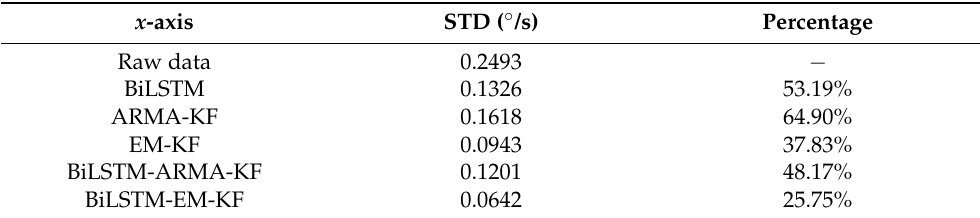
Figure 9. Comparison of error compensation performance of BiLSTM-EM-KF and BiLSTM-ARMA-KF. ( a ) Part of the x -axis data zoomed-in and ( b ) part of the z -axis data zoomed-in. Table 10. Comparison of raw data, BiLSTM, ARMA-KF, EM-KF, BiLSTM-ARMA-KF, and BiLSTM-EM-KF standard deviation values for x -axis data.